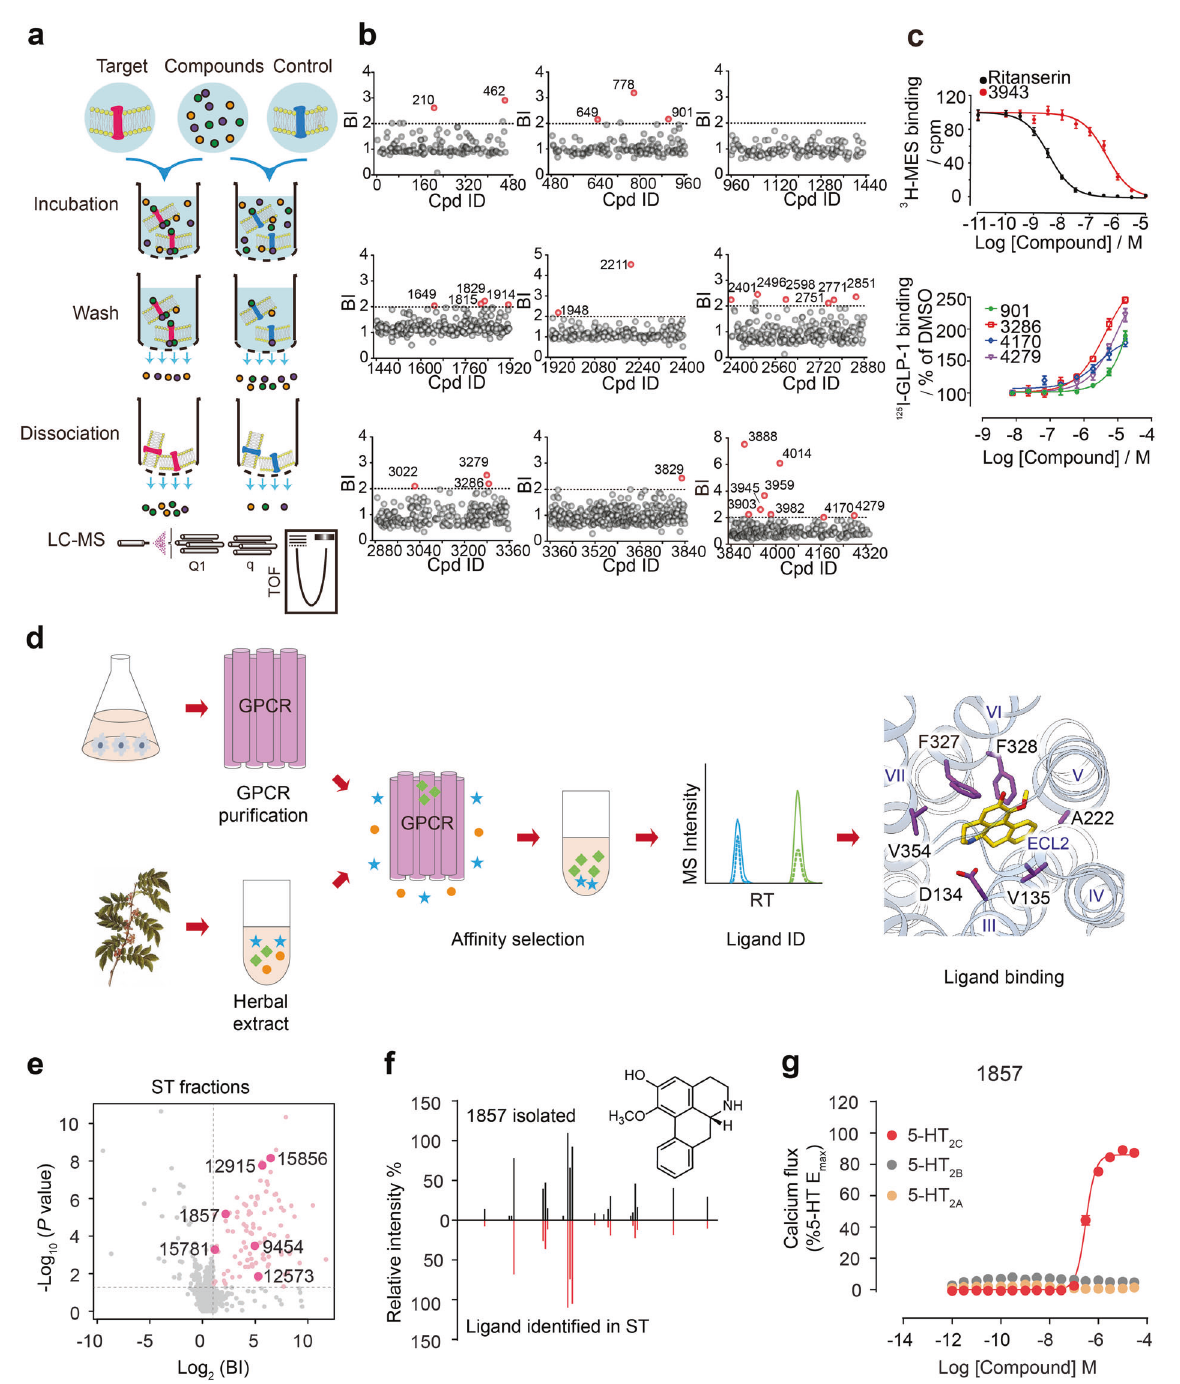
Fig. 11 Developing af fi nity MS approaches for GPCR ligand screening. a Experimental work fl ow of membrane-based af fi nity MS. b Membrane- based af fi nity MS screening of 4333 compounds split into 9 cocktails against GLP-1R. Initial hits are indicated by red dots, while gray dots represent negatives. c Binding of one new ligand to 5-HT 2C (upper) and four new ligands to GLP-1R (lower) were validated by a radioligand- binding assay. d Experimental work fl ow of af fi nity MS-based screening of natural herb extracts. e Initial hits from screening fractionated herbal extracts toward 5-HT 2C . Aporphines are annotated with larger pink dots. BI binding index. f Structural validation of 1857 by MSMS analysis. g 1857 displayed selective agonism at 5-HT 2C . Source: adapted from Qin et al. 266 and Zhang et al. 282 an antagonist for the 5-HT 2C receptor and four PAMs for GLP-1R assignment (Fig. 11a). Each incubation consumed about 2 µg membrane-embedded GPCR protein with a pool of 480 com- that are not reported previously 266 (Fig. 11c). pounds. Primary hits were selected based on the binding index More recently, the same team devised another af fi nity MS (BI) derived from quantitative MS signals used to distinguish strategy that enabled screening of 20,000 compounds in one putative ligands from non-speci fi c binders (Fig. 11b). Screening a pool. 275 Speci fi cally, they modi fi ed the work fl ow by performing small compound library with this approach led to the discovery of iterative rounds of af fi nity selection for compounds associated Signal Transduction and Targeted Therapy (2021)